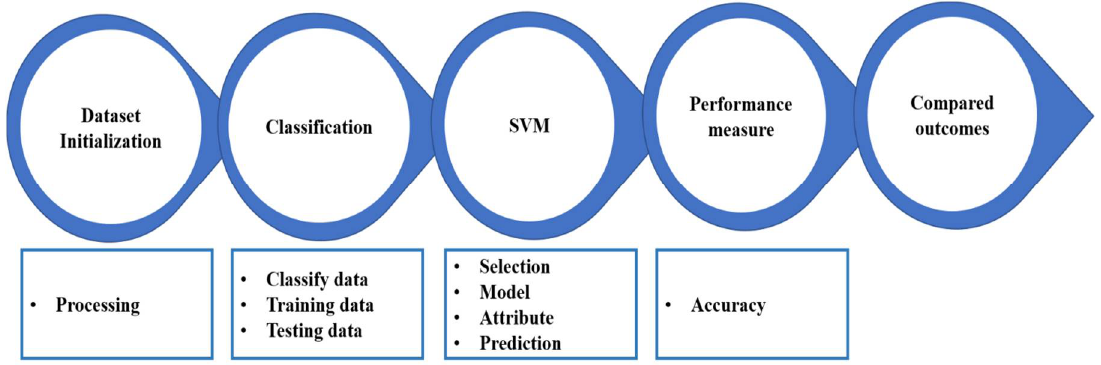
Figure 2. Action stream architecture for the vehicular ad hoc network (VANET) prediction.